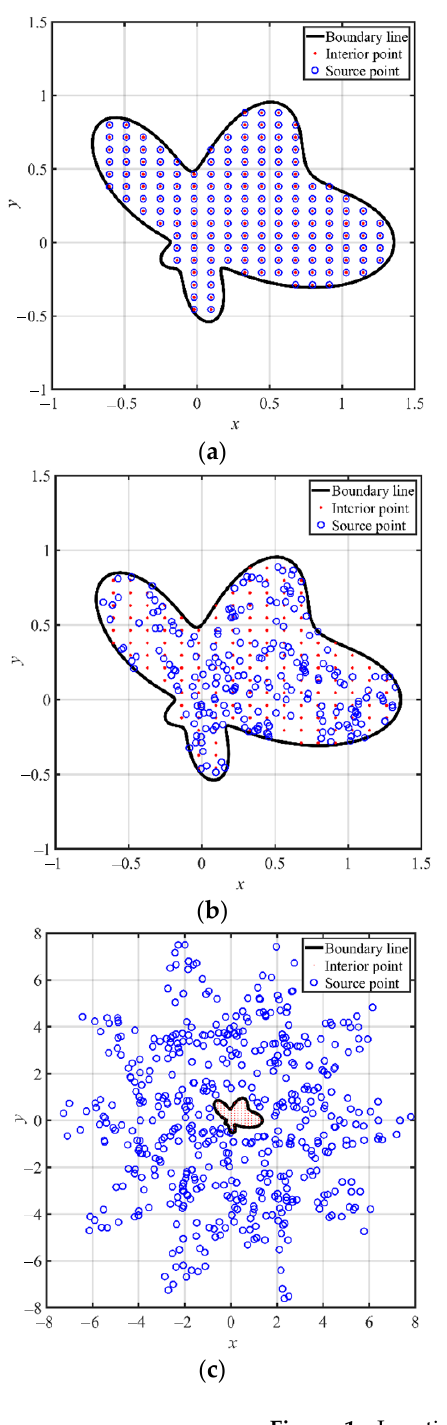
Figure 1. Location of the fictitious sources for the two-dimensional and three-dimensional domain. ( a ) A two-dimensional domain: Type A. ( b ) A two-dimensional domain: Type B. ( c ) A two-dimensional domain: Type C. ( d ) A three-dimensional domain: Type A. ( e ) A three-dimensional domain: Type B. ( f ) A three-dimensional domain: Type C.